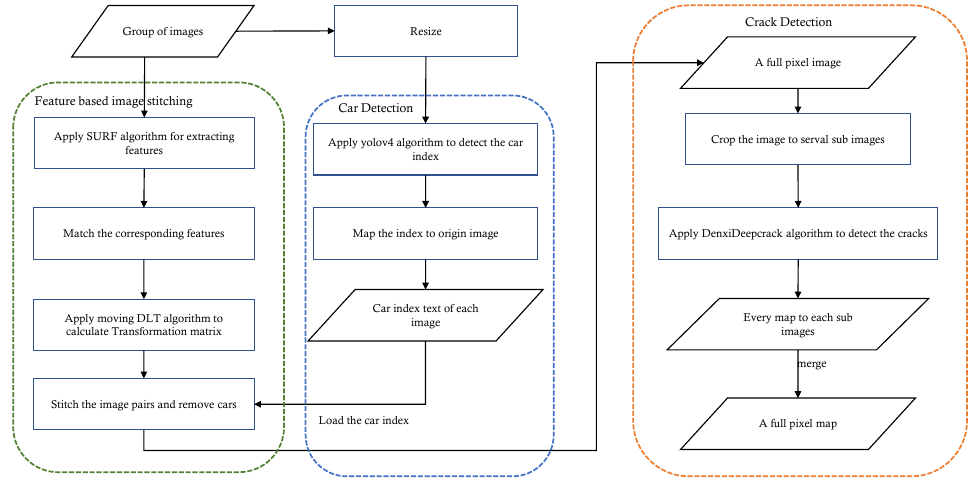
Figure 1. Flowchart of the proposed